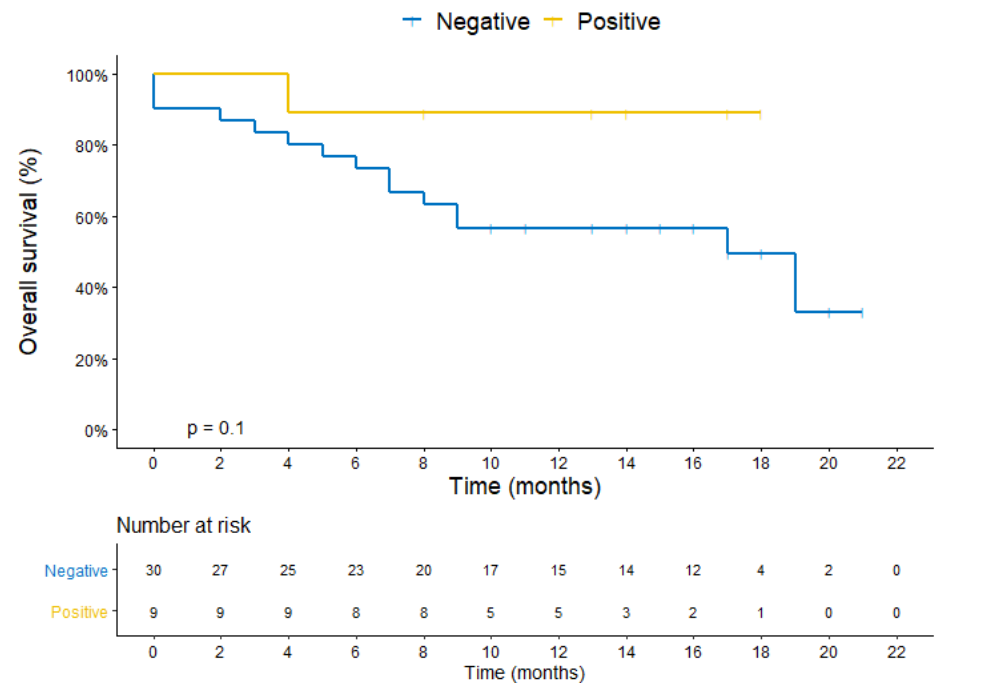
Figure 5. Kaplan – Meier plot for overall survival stratified by HER2 expression in the CTC1 or Figure 5. Kaplan–Meier plot for overall survival stratified by HER2 expression in the CTC1 or CTC2.